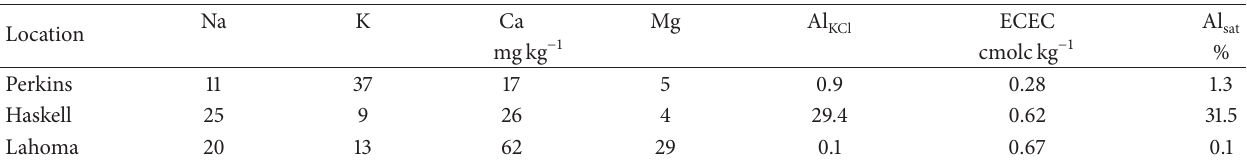
Table 1: Initial soil fertility conditions at Perkins, Haskell, and Lahoma, Oklahoma. Soil fertility is characterized by extractable sodium (Na), potassium (K), calcium (Ca), magnesium (Mg), aluminum (Al ). (Al sat